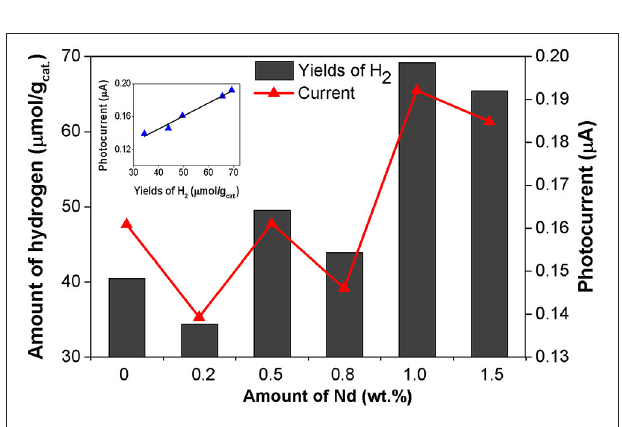
FIGURE 8 | Correlation between the photocatalytic activity in the CH 3 OH photocatalytic decomposition in the presence of Nd/TiO 2 photocatalysts and current generation. Current responses were obtained at 360nm under external potential of